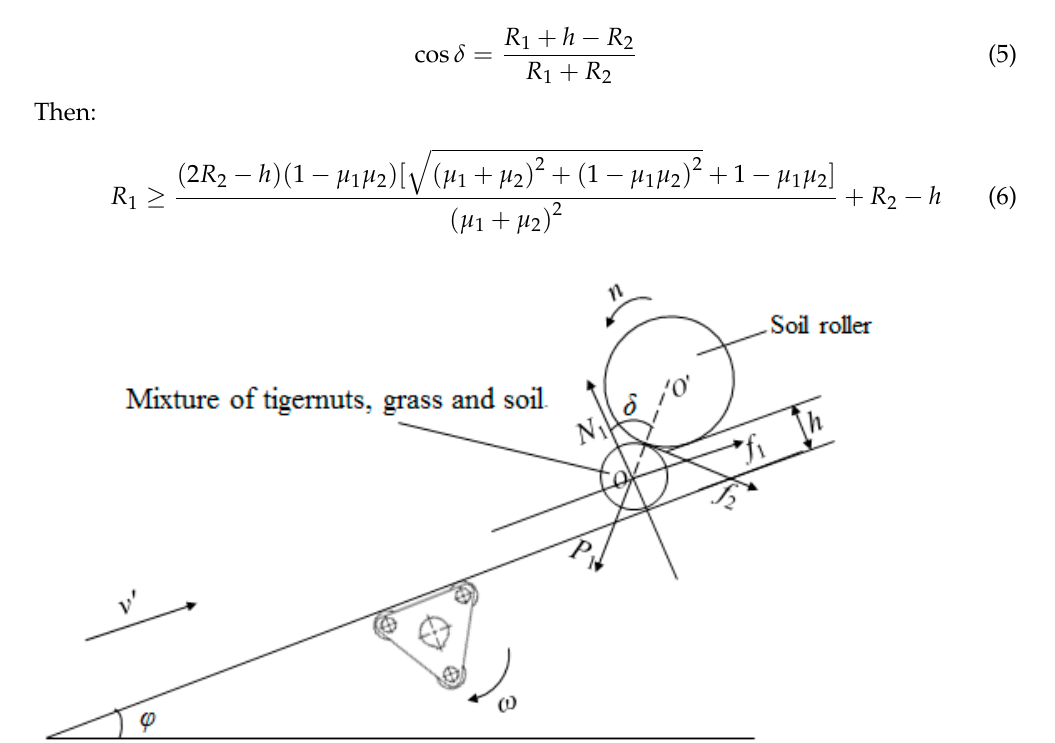
Figure 5. Schematic diagram of soil fragmentation. Based on Equation (6), the radius of the soil roller and the radius of the tiger nut, soil and grass blend, the coefficient of the frictions among the hoisting chain, the soil roller and the blend are set, which are related to the spacing between the soil roller and the sieve surface. Among them, the spacing between soil roller and sieve surface h should be equal to or greater than R 2 min. Pacing lower than R 2 min will result in the clogging of soil lumps on the sieve surface, which makes the operation fail to produce reflux, further influencing the conveying efficiency of the hoisting device. On-site measurement was conducted on the radius of the blend with R 2 ranging from 50 to 150 mm. Based on the aforementioned analysis, the minimum radius R 1 min of the soil roller is 53 mm based on Equation